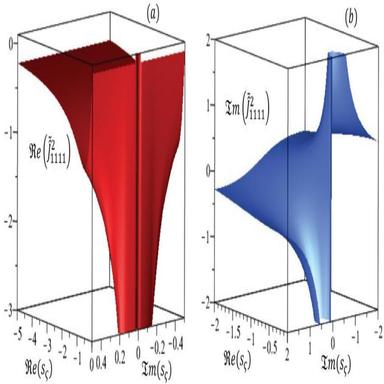
(a) Dimensionless real part component Re(˜ˆJ 2 1111 ) vs. Re(sς ) and Im(sς ). (a) Dimensionless imaginary part component Im(˜ˆJ 2 1111 ) vs. Re(sς ) and Im(sς ). Both are retrieved for rρ = 10, rE = 10, τ i ς = 10, i = 1, 2, ν˜1 = ν˜2 = 0.2, η = 1 and γ = 1.